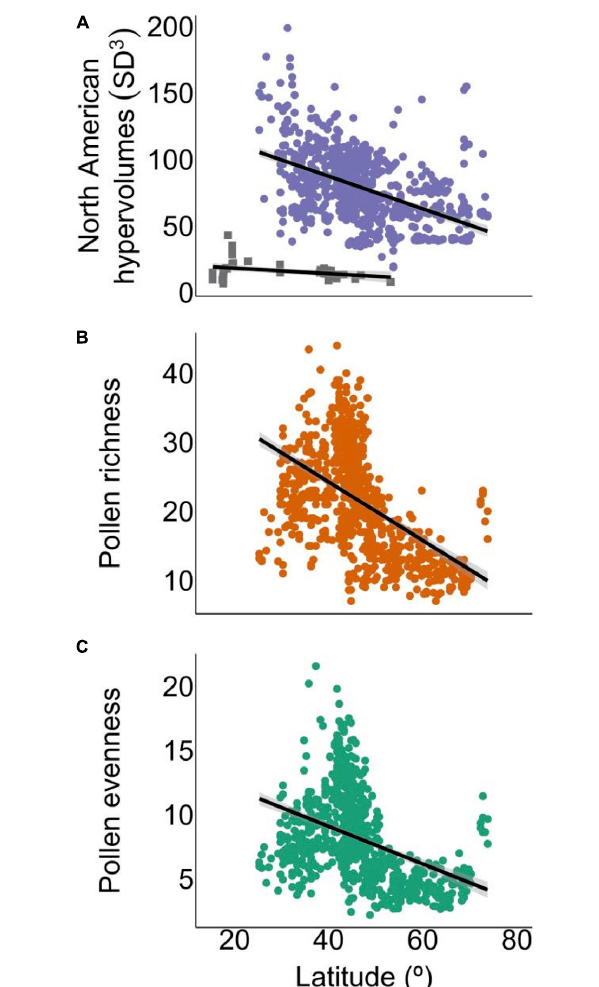
FIGURE 3 | The North American functional diversity gradient estimated from surface pollen samples (purple points, estimated in this study based on data from the Neotoma Paleoecology Database, Williams et al., 2018) and tree assemblages (gray points, Lamanna et al., 2014) (A) , with pollen indices of richness (B) and evenness (C) . Slopes of each gradient were identified using linear modeling (black lines). Regressions indicated the functional diversity (A) and pollen richness (B) gradients were significantly related to latitude.